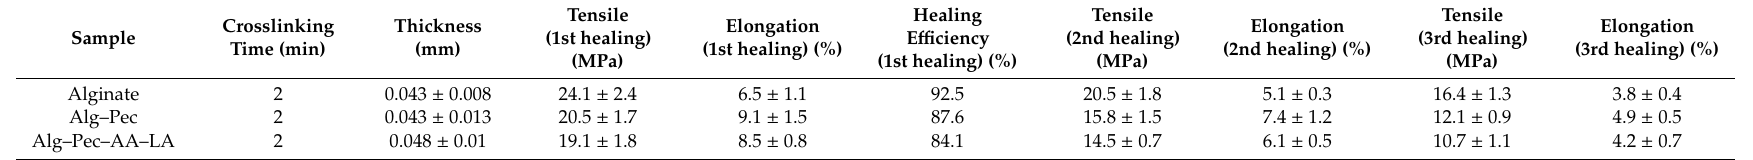
Table 4. Healing e ffi ciency of crosslinked alginate and alginate–pectin based